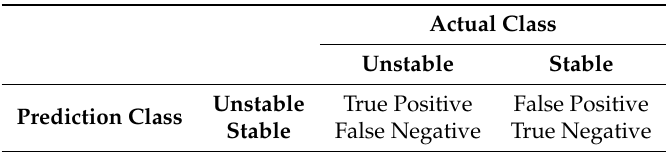
Table 3. Confusion matrix.